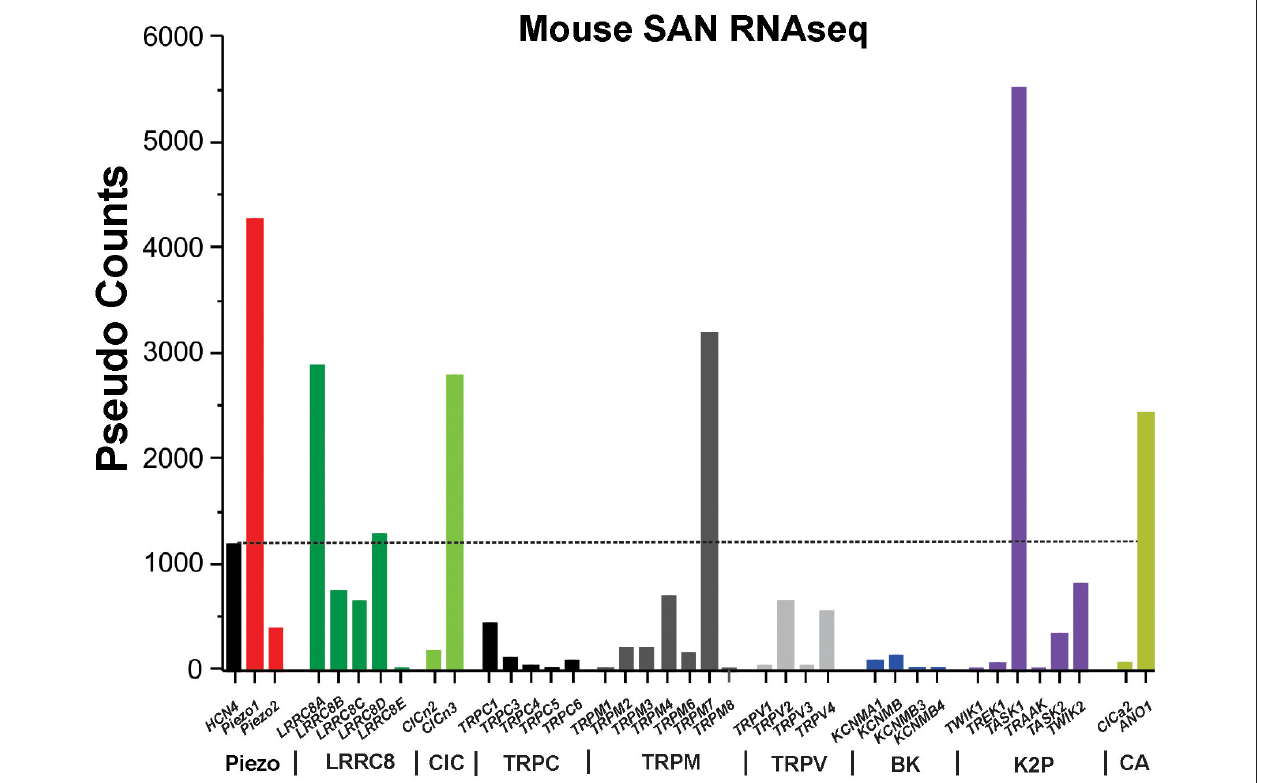
FIGURE 2 | RNAseq of mouse sinoatrial node. The graph shows the absolute values (in pseudo-counts) for mRNA expression level. Horizontal dotted line indicates HCN4 level. LRRC8, leucine-rich repeat containing 8 family chloride channels; ClC, chloride channel; TRPC/M/V, transient receptor potential cation/melastatin/vanilloid subtype ion channels; BK, Ca 2 + -activated “big” potassium ion channels; K2P, two-pore domain potassium ion channels; CA, calcium-activated chloride ion channels; HCN4, hyperpolarization activated cyclic nucleotide gated cation channel